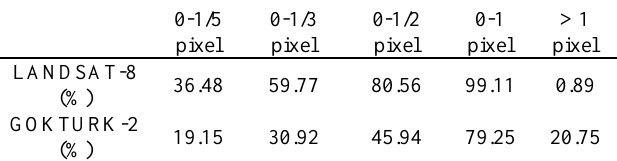
Table 5. Calculated distance ratios in pixel